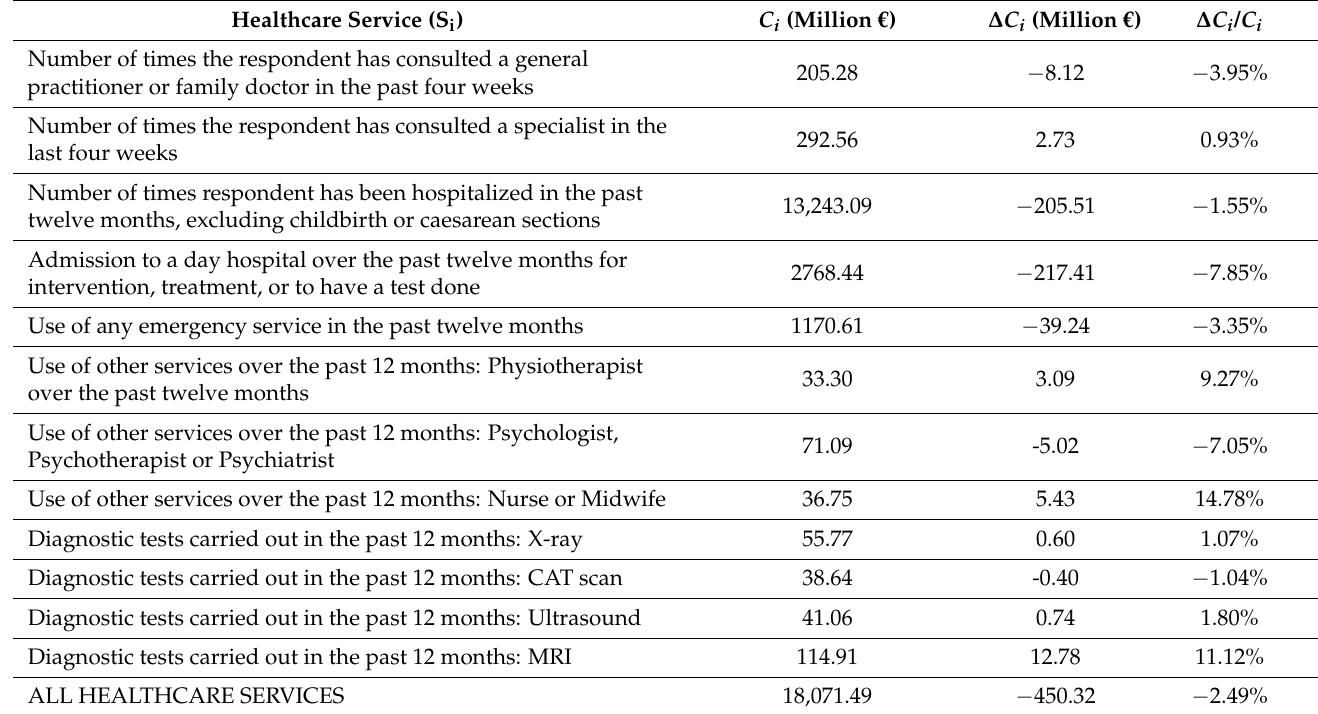
Table 7. Costs of healthcare services and reduction by